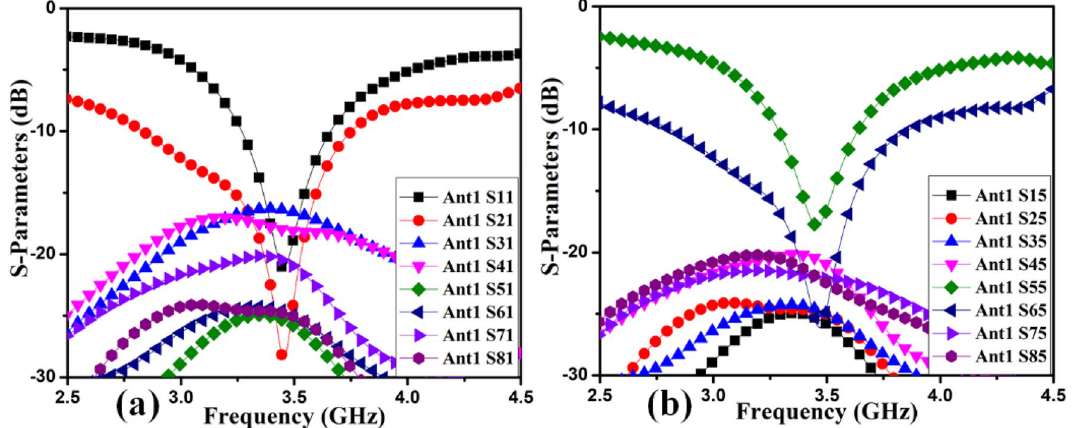
Figure 13. Simulated S-parameter results ( a ) Ant 1, ( b ) Ant